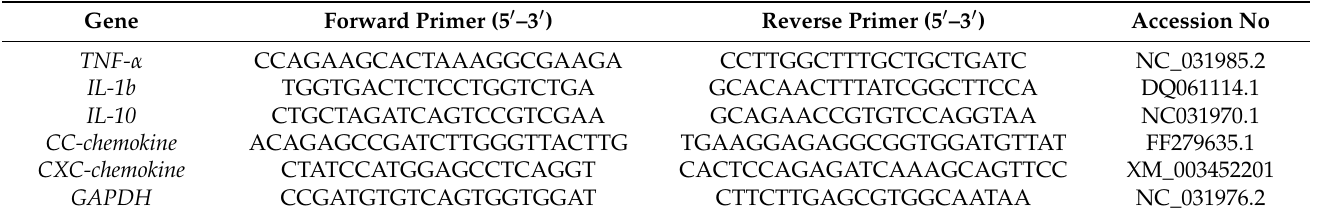
Table 3. Primer sequences used in